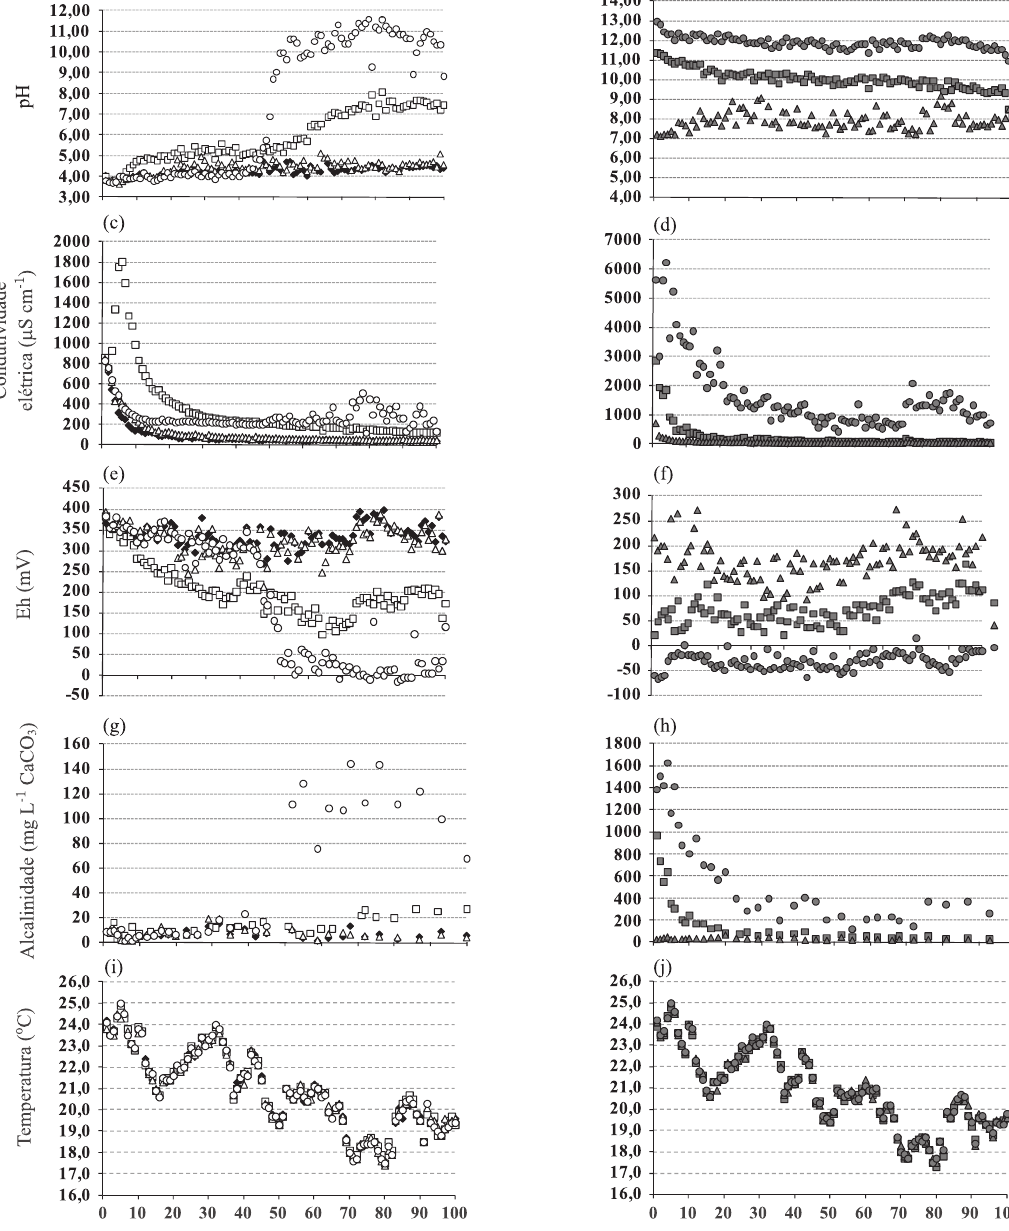
Figura 2. variações de pH, condutividade elétrica, eh, alcalinidade e temperatura ao longo do